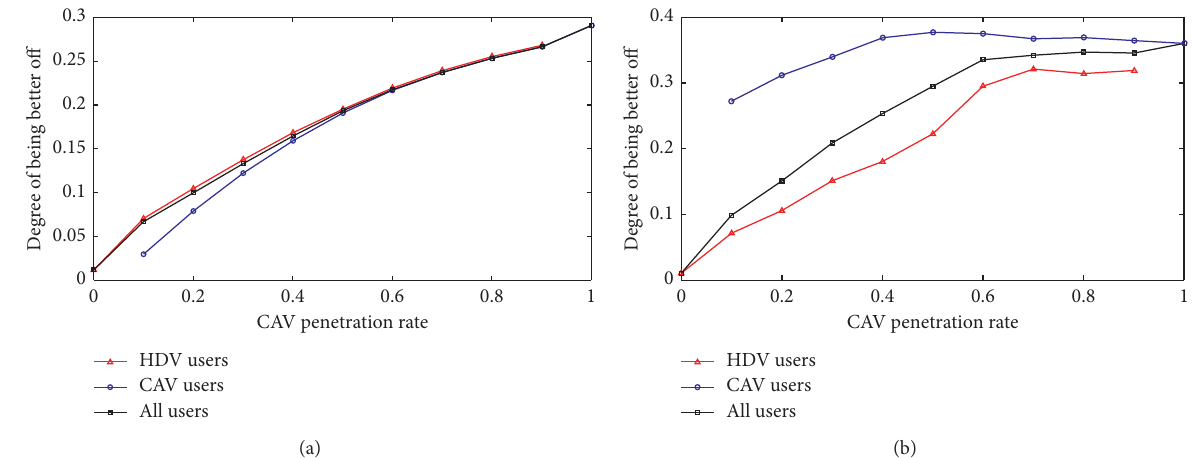
Figure 3: Improvement on network performance under tradable credit scheme. (a) Degree of being better off without AVCC link. (b) Degree of being better off with AVCC link.